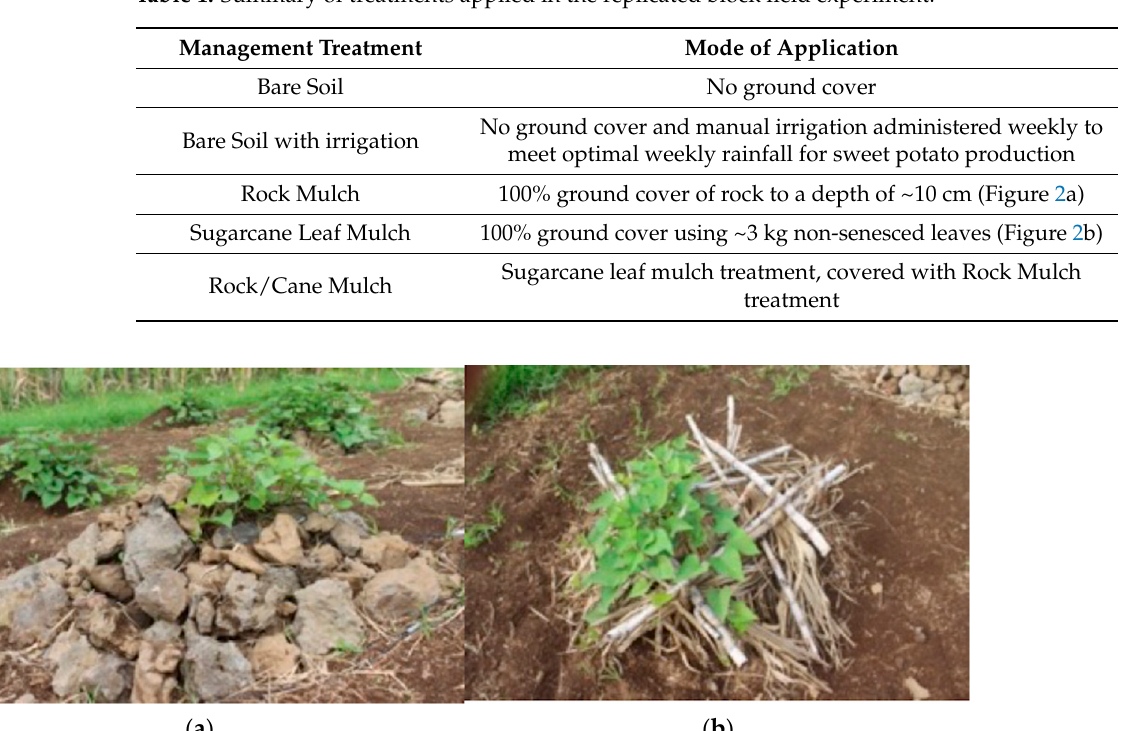
Table 1. Summary of treatments applied in the replicated block field experiment.